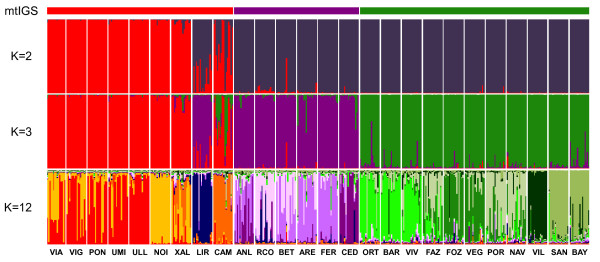
Genetic subdivision of Iberian Fucus ceranoides based on STRUCTURE. Shown are the proportions of individual multilocus genotypes assigned to each of K virtual clusters, as illustrated by the different colours. The individuals from VIA, VIL, SAN and BAY were also included. Population codes are given in Table 1.